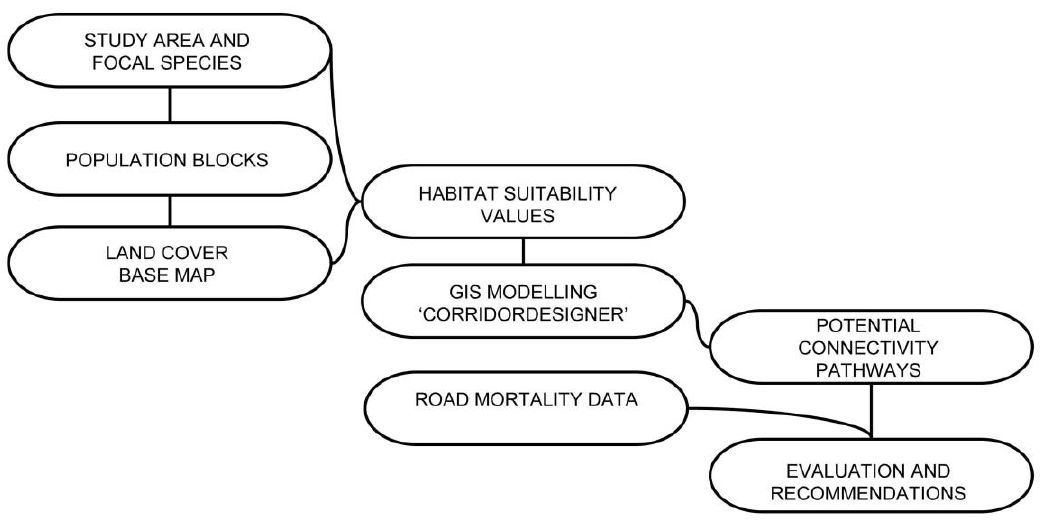
Figure 1. Schematic diagram of methods used to model and evaluate potential connectivity pathways for the Massasauga rattlesnake in an urban park system in southwestern Ontario, Canada.